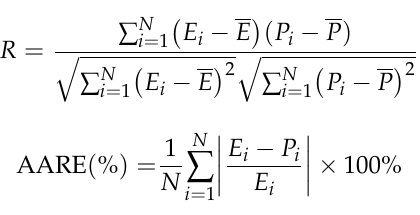
Table 3. Correlation coefficient and relative average error corresponding to different orders.